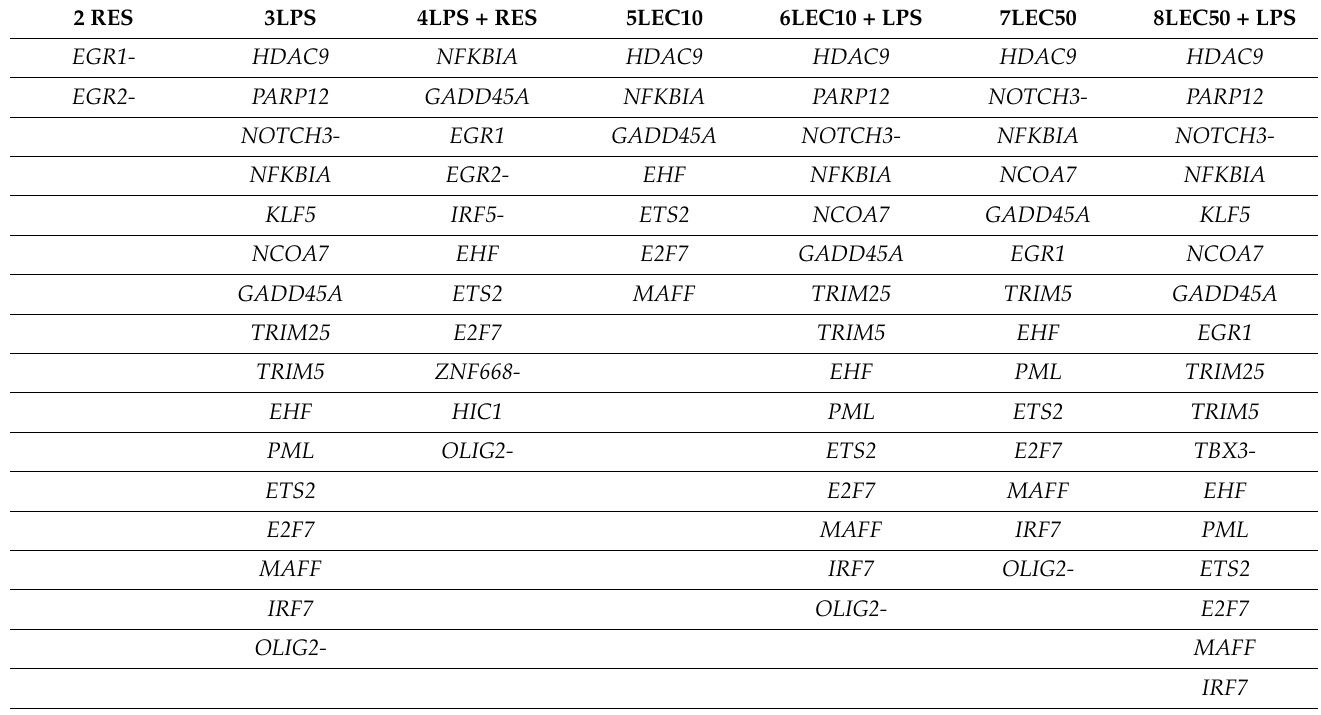
Table 5. Transcription factor genes modulated by different treatments